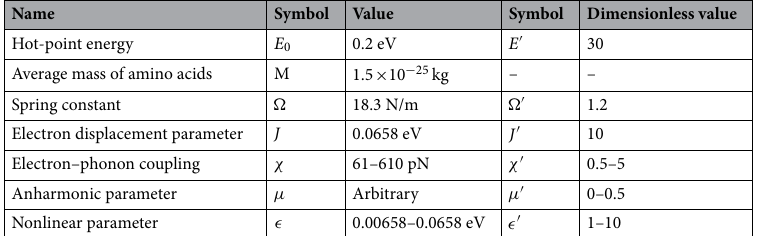
Table 2. Values of the parameters used in the numerical simulations. Physical versus dimensionless values are